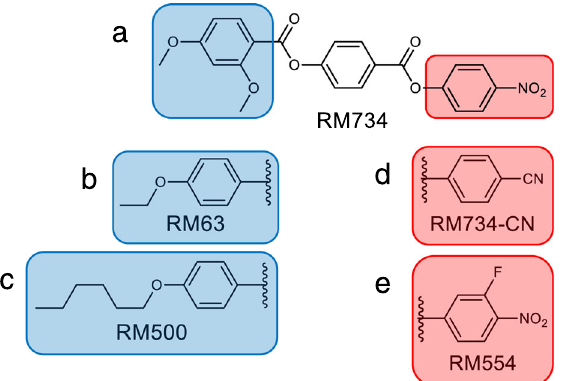
Table 2 Calculated order parameters and density for the RM734 variants.